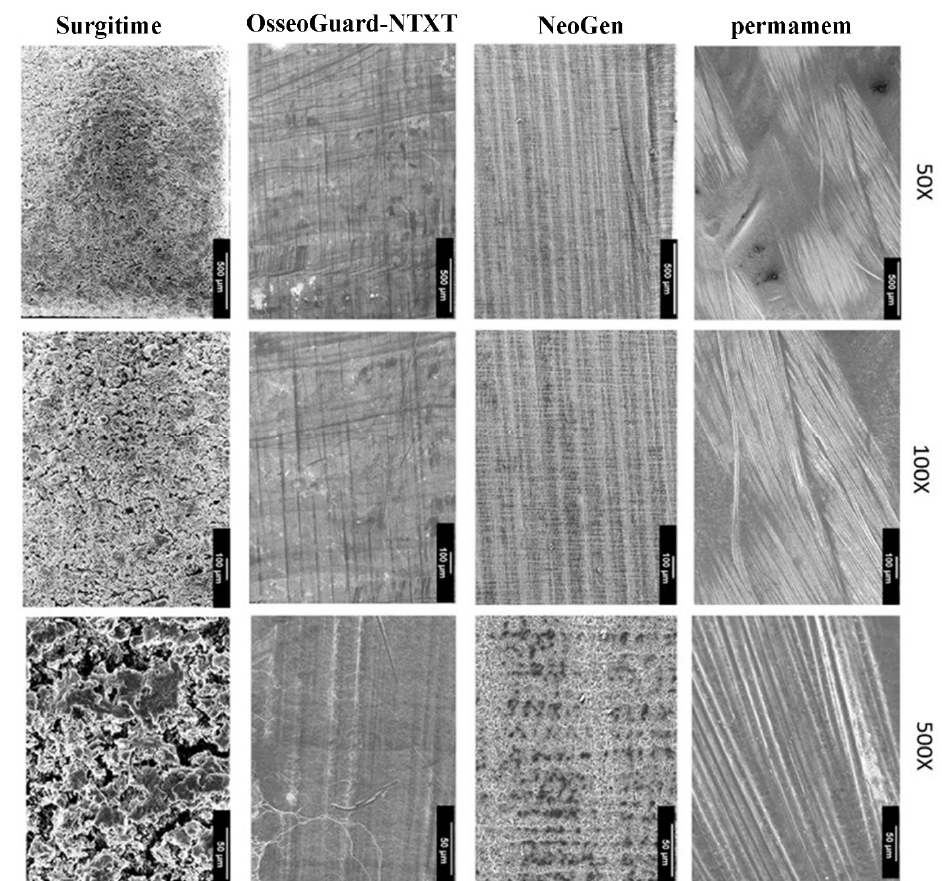
Figure 1. SEM images of the soft tissue-facing site of the non-textured PTFE. Both Cytoplast TM TXT-200 and OsseoGuard ® -TXT displayed a non-fibrillar structure with evenly distributed hexagonal-shaped indentations (Figure 2). These indentations had a 500 µm width with 250 µm spacing in between. The depth of these indentations was less than the core thickness of the membranes, both were very similar in surface features and no pores were seen.